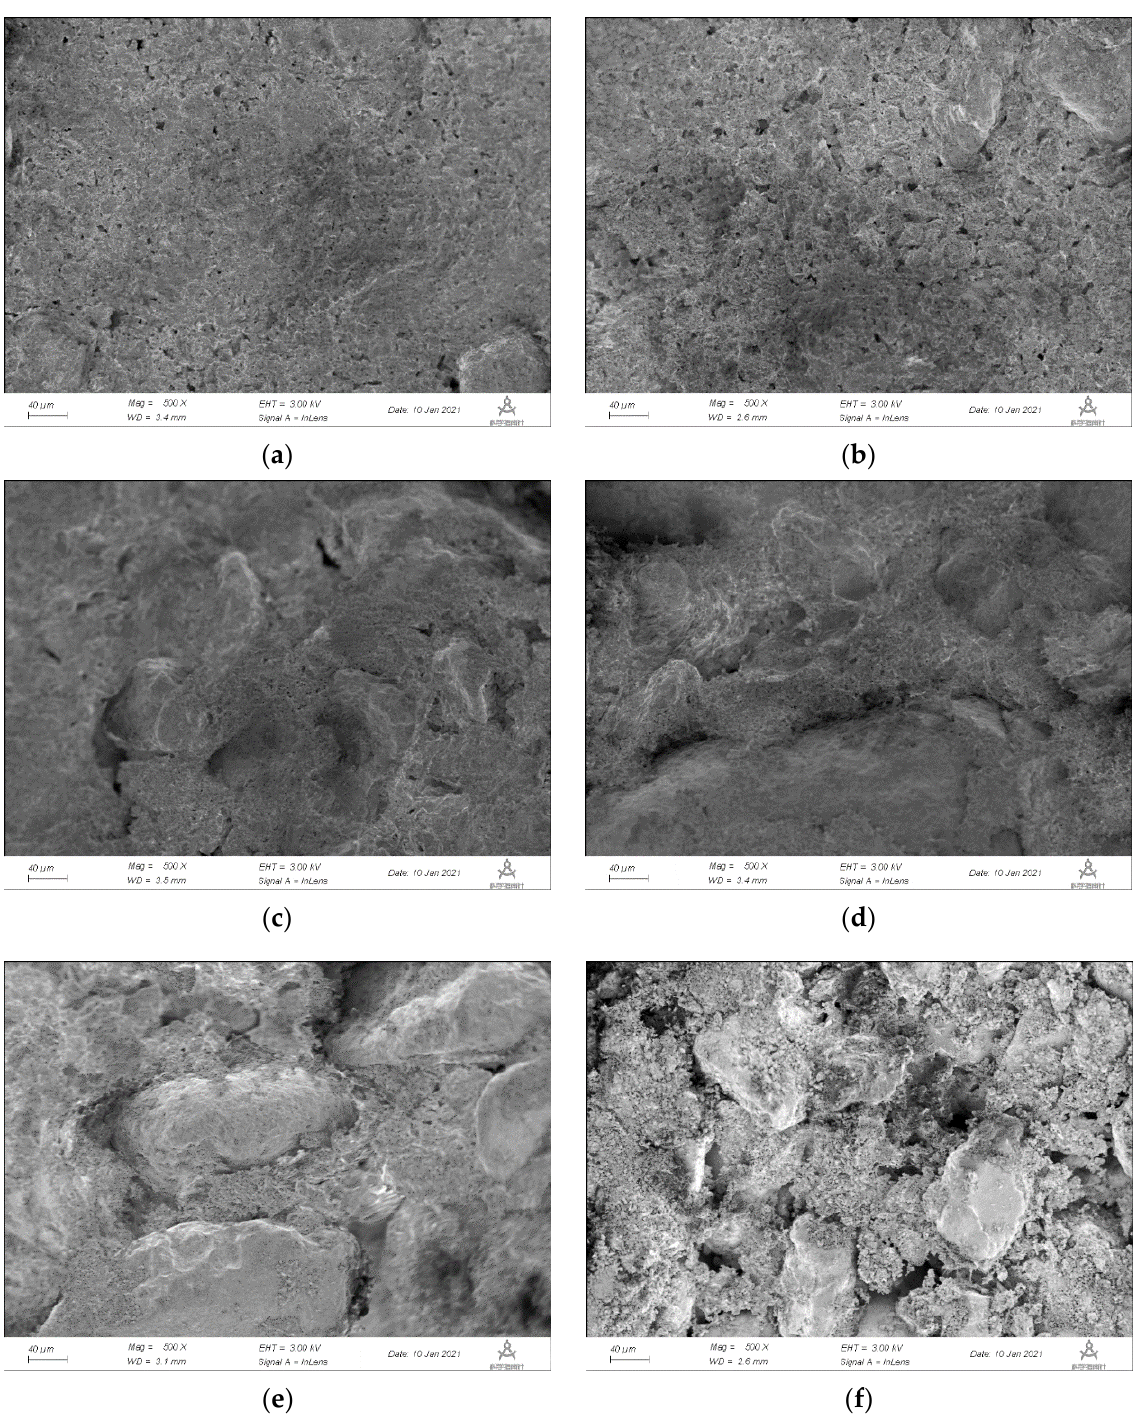
Figure 6. Void distribution within the material. ( a ) 400 W 200 min, ( b ) 400 W 300 min, ( c ) 1200 W 120 s, ( d ) 1200 W 240 s, ( e ) 2000 W 80 s, ( f ) 2000 W 120 s.